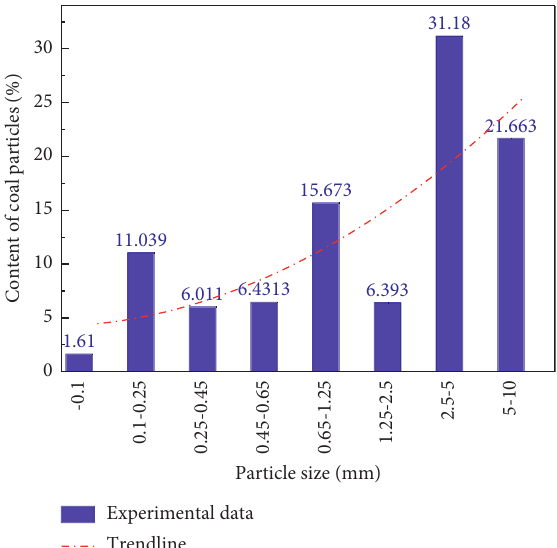
Figure 5: Particle size distribution of raw coal.